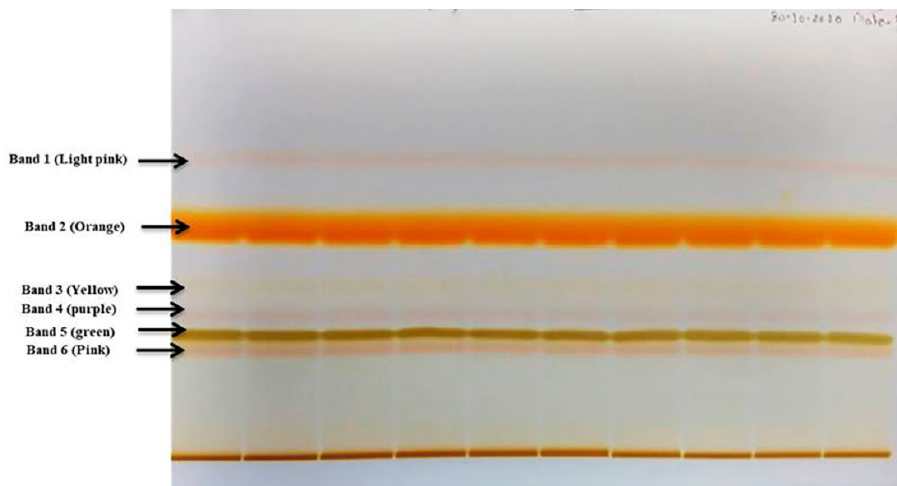
Figure 14. Separation of compounds in the crude pigment of G. triuniae NFCCI 4873 on TLC plate using HP-TLC.